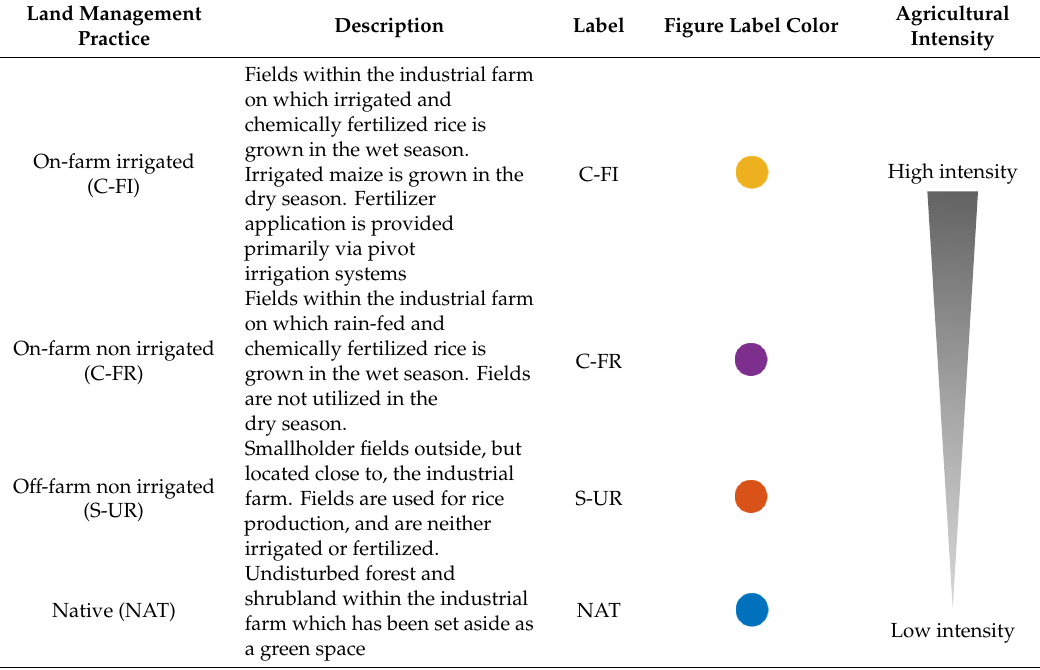
Table 1. Land management practices on the locations selected for soil sampling.